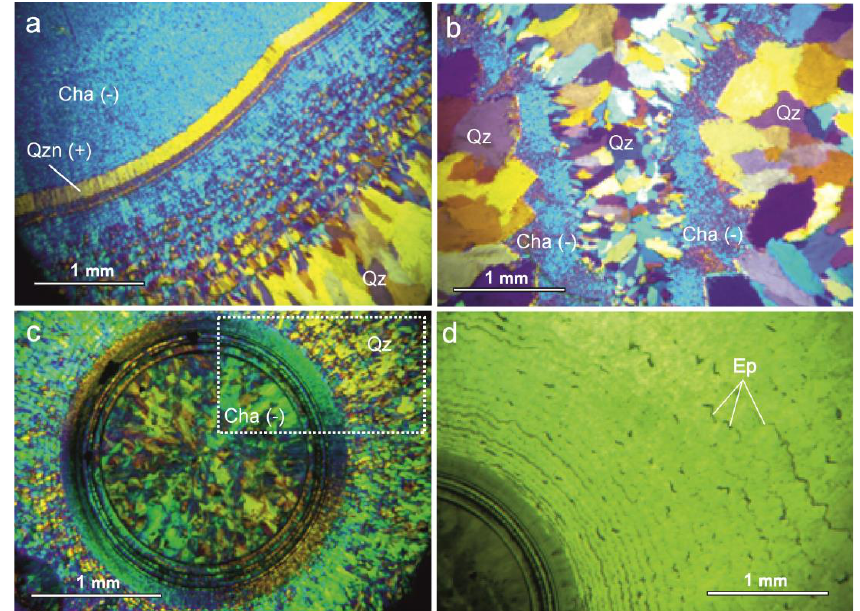
Figure 5. Microphotographs of Onega agates: ( a ) alternating zones of fibrous and flaked chalcedony, quartzine, and inequigranular quartz in concentric zonal agate (Pinguba); ( b ) internal part of the agate formed by euhedral quartz grains and flaked chalcedony (Pinguba); ( c ) spherolite of chalcedony in microcrystalline quartz matrix (Tulguba); ( d ) epidote inclusions developed at the edges of quartz grains (corresponds to dotted field in figure ( c )). Cha(-): chalcedony, Qzn( + ): quartzine, Qz: quartz, Ep: epidote. ( a – c )—polarized light, crossed nicols, compensator plate; ( d )—transmitted light, parallel